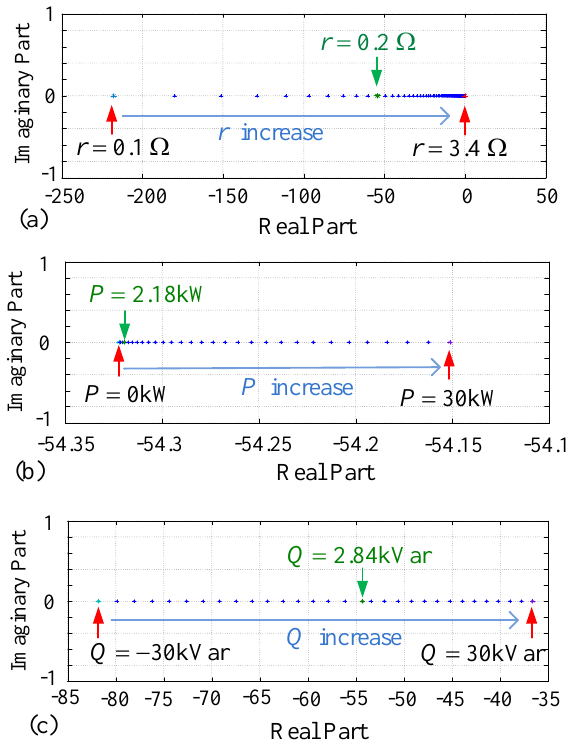
Figure 5. Dominant pole of Equation (13) for different conditions: ( a ) different line resistances; ( b ) different load active power; and ( c ) different load reactive power.